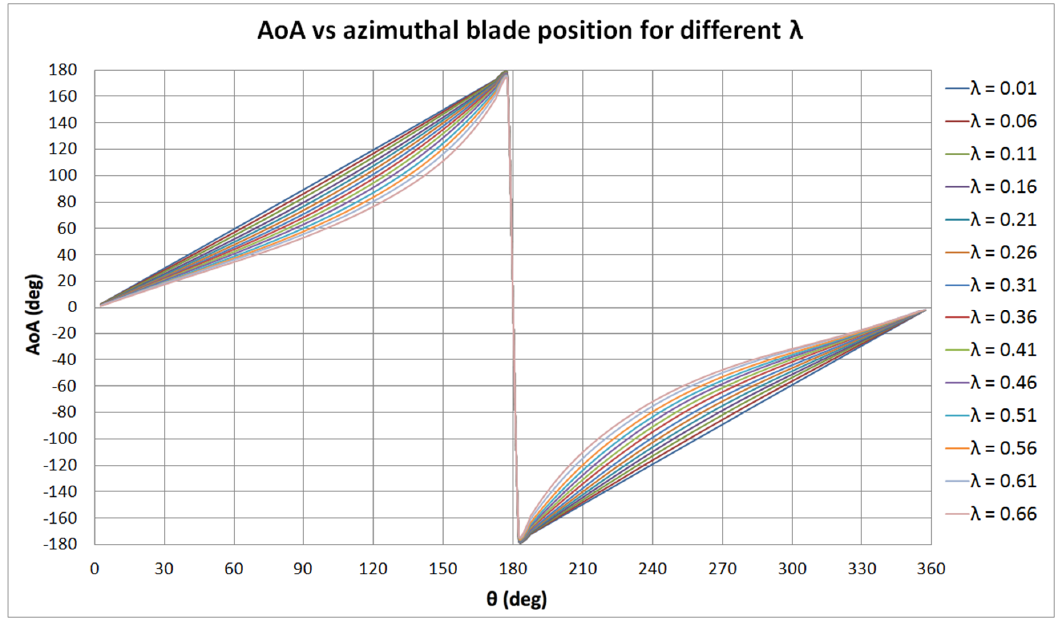
Figure 15. Qblade calculated local AoA as a function of the azimuthal blade position for different tip speed ratios.